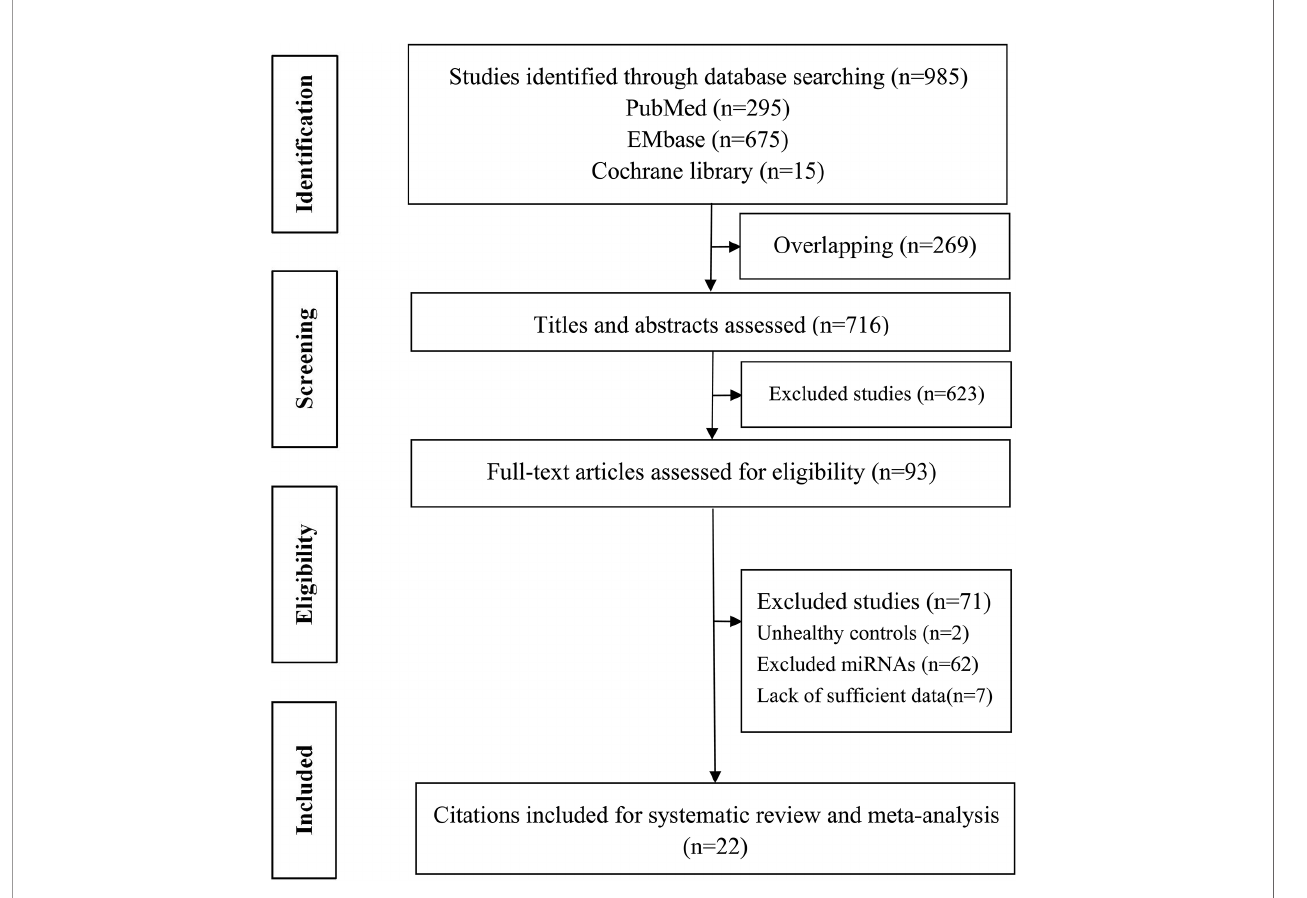
FIGURE 1 | PRISMA Flow diagram of the literature during the review process for the systematic review and